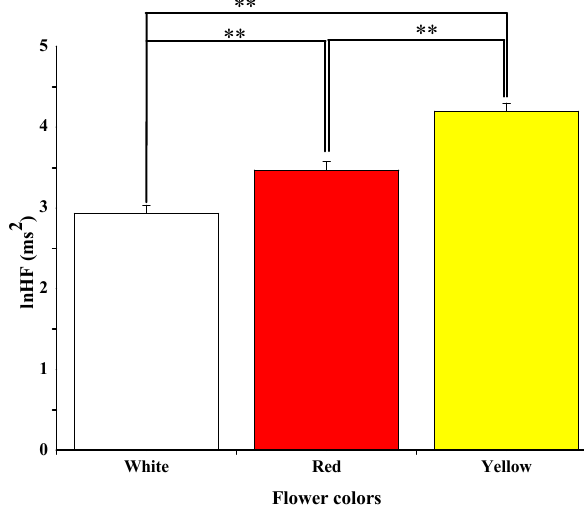
Figure 5. Average of the high-frequency component (HF) of heart rate when seeing white, red, and yellow flowers. ** p < 0.01 defined by Bonferroni correction.